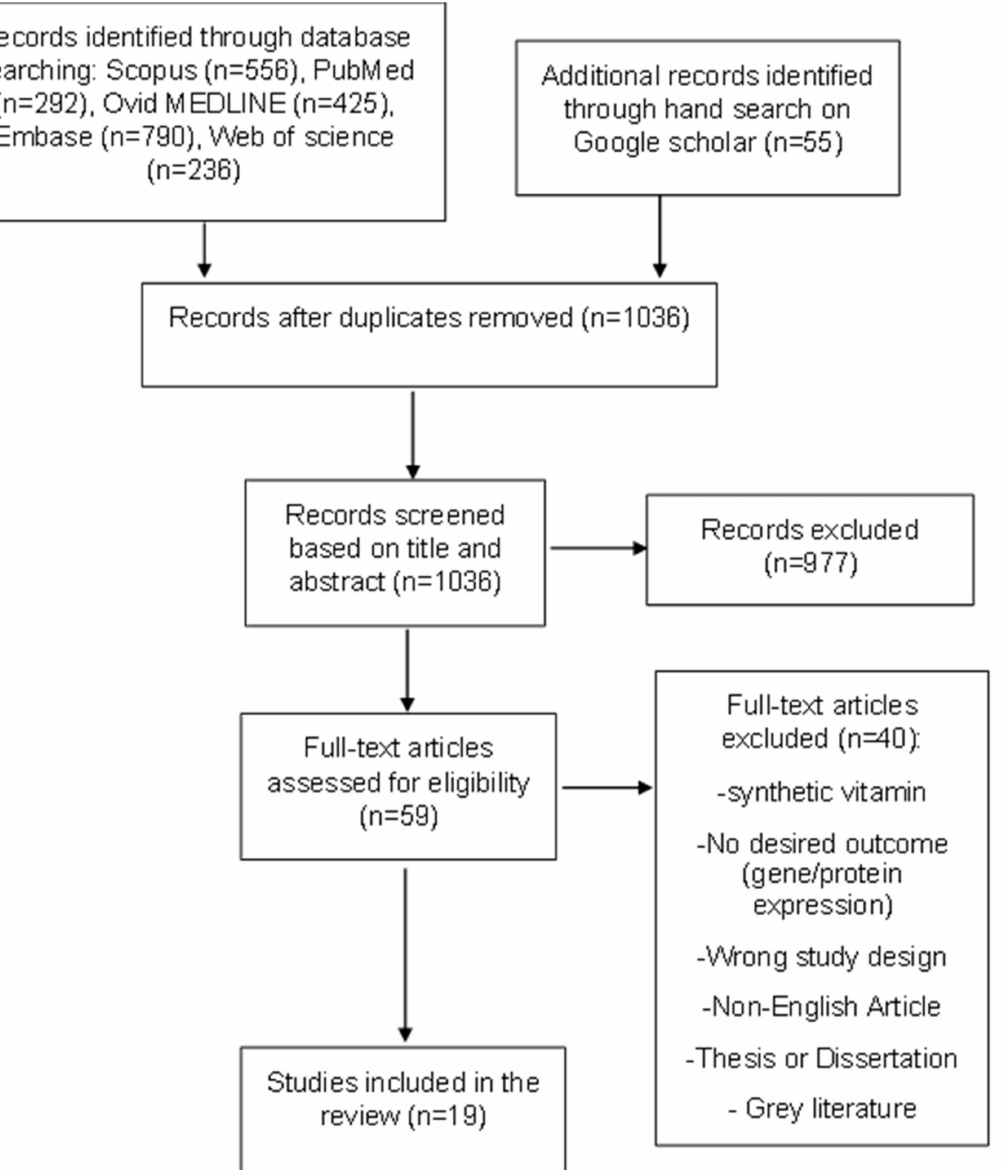
Figure 1. Systematic review PRISMA chart showing the literature search from 2005 to June